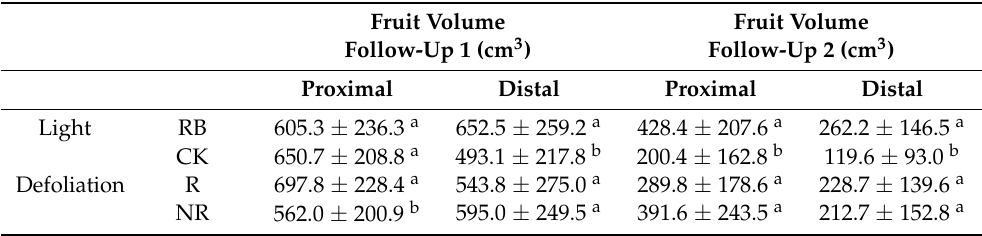
Table 3. Effects of the two separated factors, light (supplemental red and blue LED light, RB, and natural light, CK) and defoliation (early leaf removal, R, and no-removal, NR), on fruit volume (cm 3 ) in proximal and distal tomatoes of Follow-Up 1 and Follow-Up 2 Different letters indicate significant differences at ANOVA (significant level p ≤